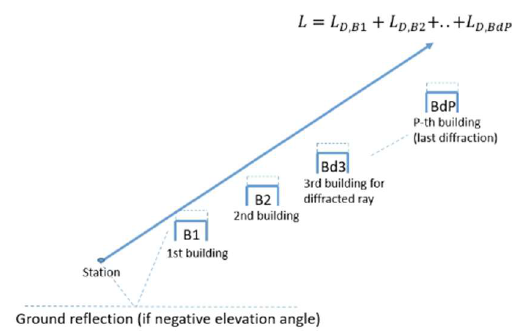
Figure 9. Clutter loss calculation for the LoS scenario.